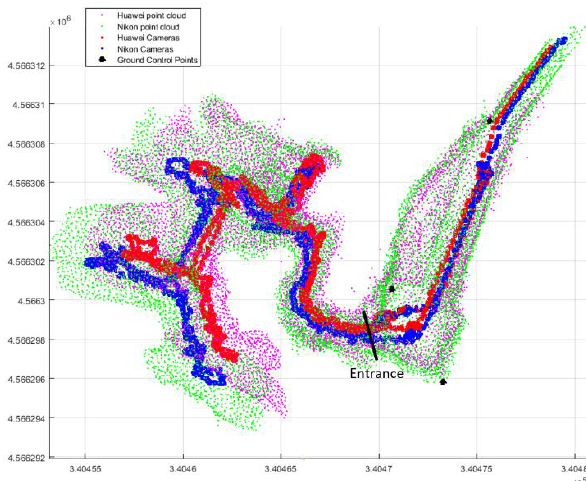
Figure 7. The mapping of the point clouds and relative cameras.